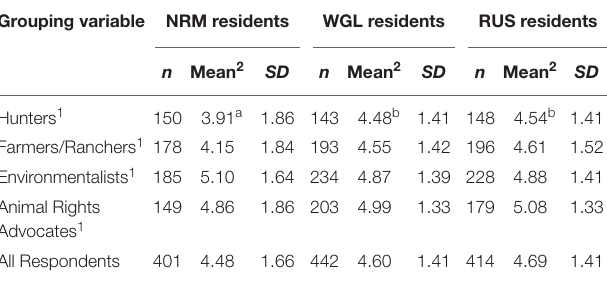
TABLE 1 | One-way ANOVA results depicting differences in attitudes toward wolves by region among United States residents who identify with particular groups